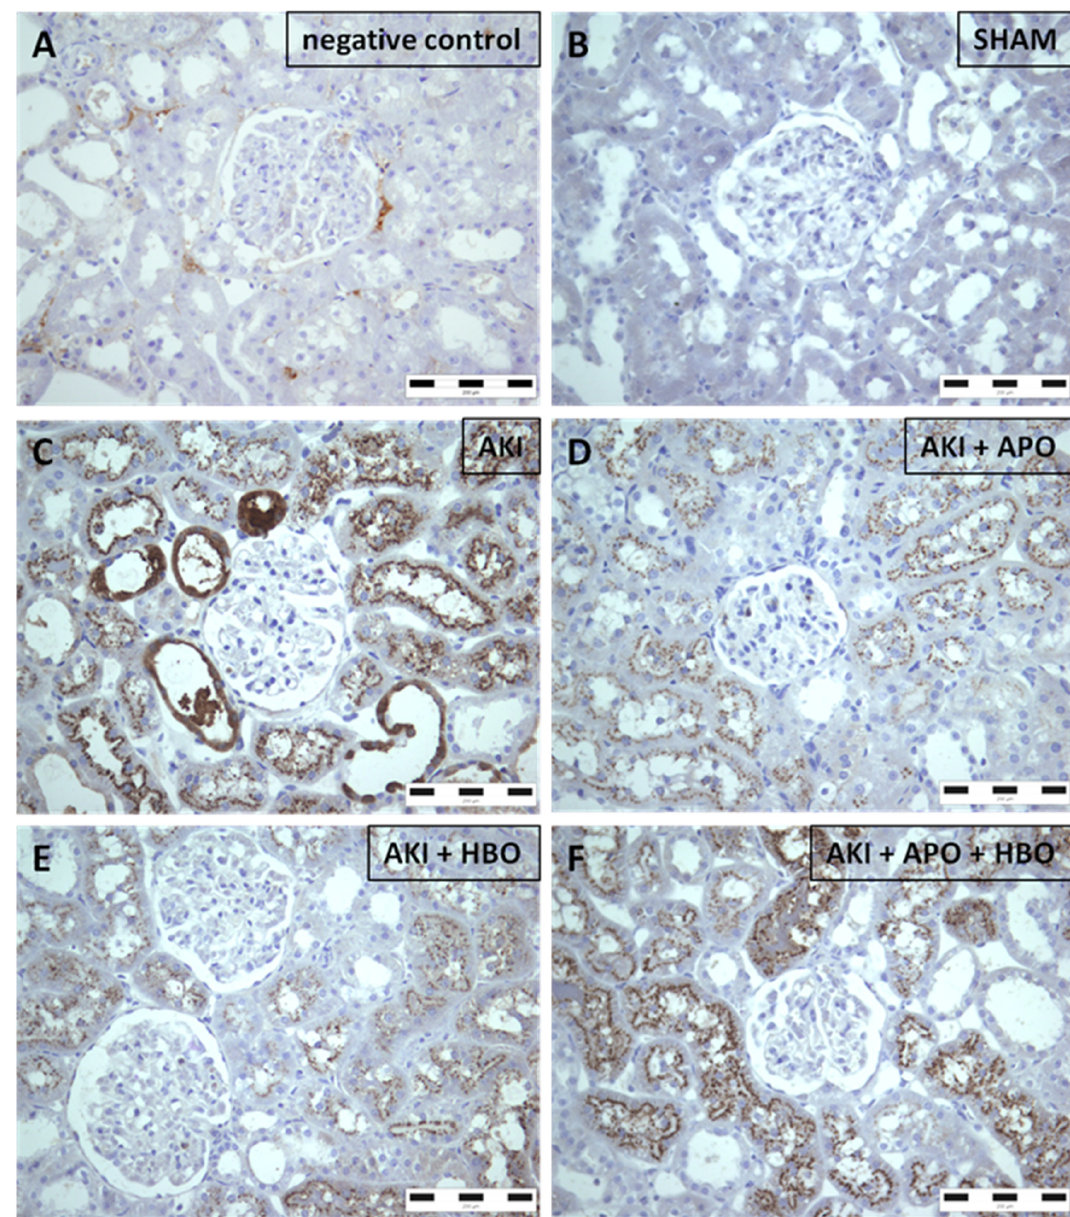
Figure 5. Immunohistochemical neutrophil gelatinase-associated lipocalin (NGAL) expression in representative kidney samples collected in different experimental groups (× 400 magnification): negative control ( A ), SHAM ( B ), AKI ( C ), AKI + APO ( D ), AKI + HBO ( E ), AKI + APO + HBO ( F ). SHAM—sham-operated rats; AKI—rats with induced postischemic acute kidney injury; AKI + APO—animals with acute kidney injury and apocynin treatment; AKI + HBO—group exposed to HBO preconditioning before acute kidney injury induction; AKI + APO + HBO—animals exposed to HBO preconditioning before and treated with apocynin after acute kidney injury induction.